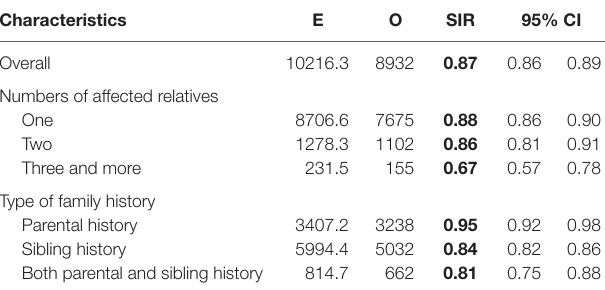
TaBle 2 | risk of prostate cancer among individuals with a family history of type 2 diabetes as compared to matched non-exposed group. characteristics